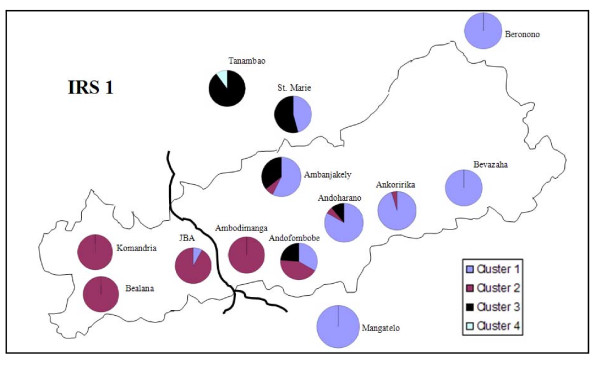
Schematic map of the sampling populations in the IRS1 with the outline of the ANP as a thin black line. The proportion of individuals of each site belonging to clusters 1-4 (see Figure 6 for the delineation of the clusters) are indicated in site-specific pie-charts.